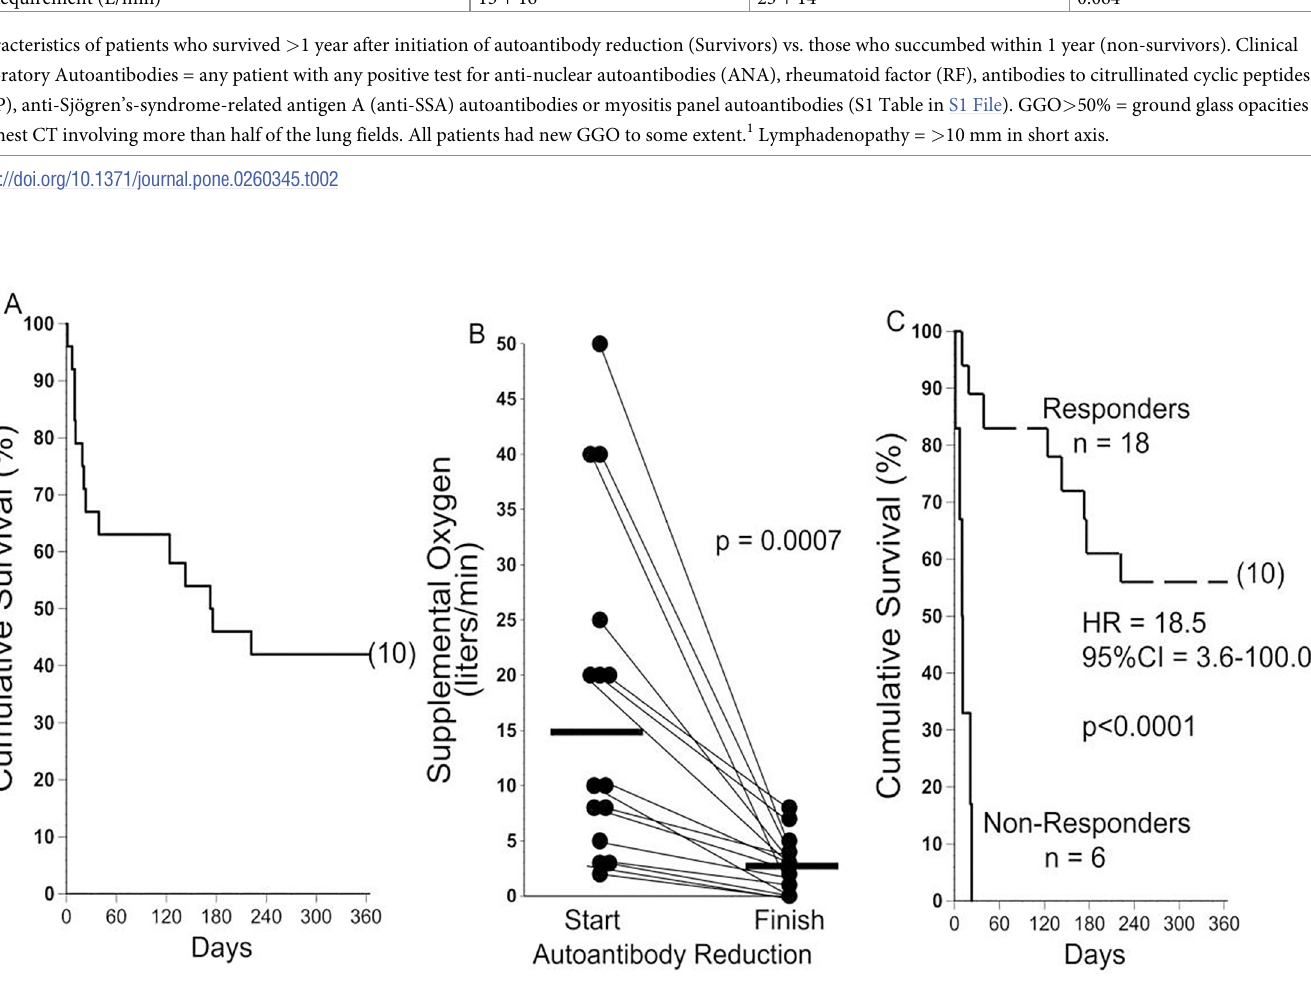
Fig 1. Overall survival and responses to autoantibody reduction therapy. A) Cumulative survival of the 24 IPF patients with acute exacerbations. Most of the mortality occurred during the first month after their presentation. Number in parentheses denotes subjects censored at the end of the observation period.